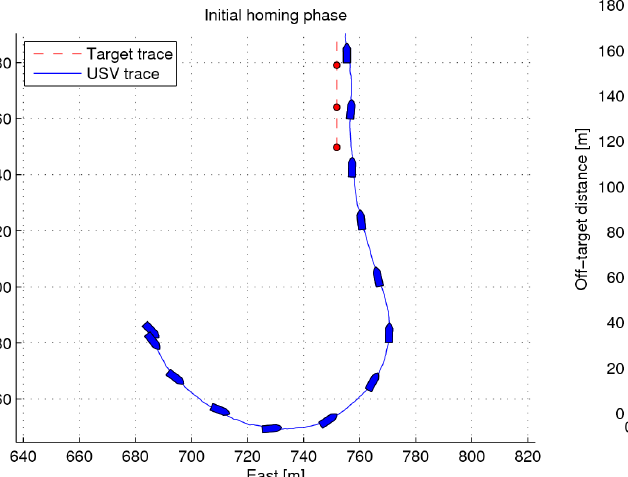
Figure 15: The distance to the target initially increases until the USV begins to move in the tar- get direction and then fi nally converges smoothly to zero.